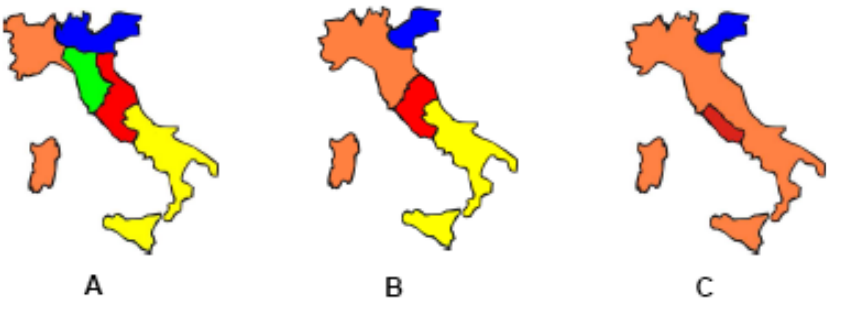
Figure 1. Maps of Italy in 1859 ( A ), 1860 ( B ) and 1861 ( C